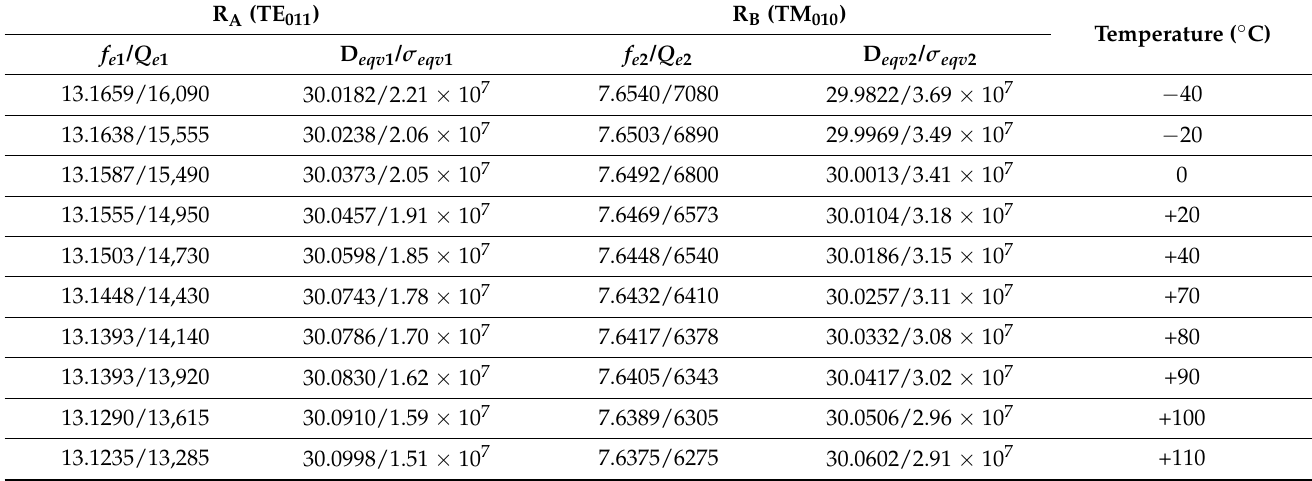
Table 4. Empty resonator (R A and R B ) parameters (units GHz, mm, S/m, ◦ C) at different temperatures.